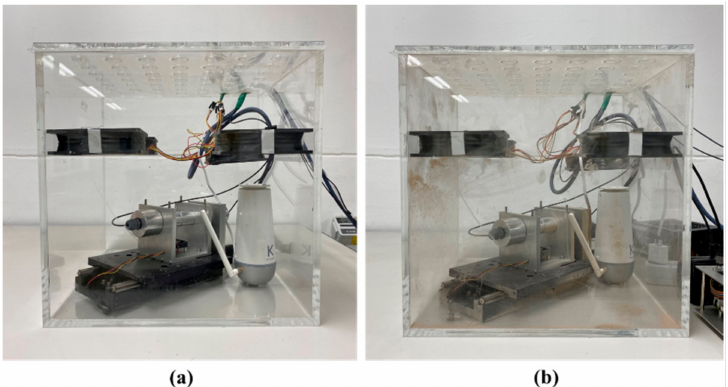
Figure 4. Photograph of the experimental setup: ( a ) without fine dust, and ( b ) with fine dust (0.012